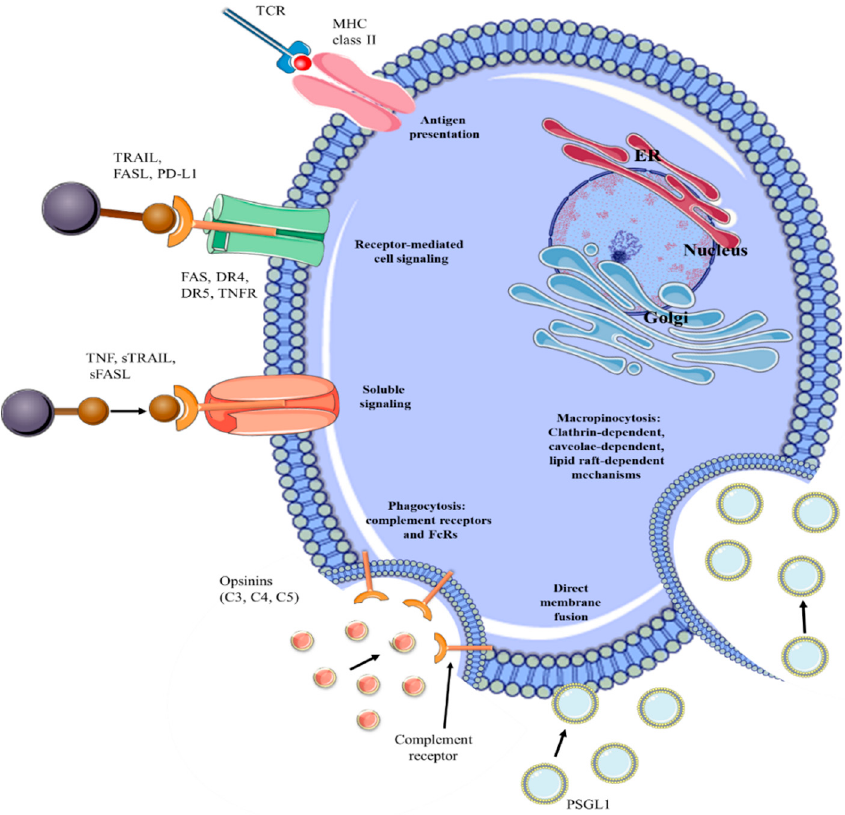
Figure 5. EV internalization by recipient cells through different mechanisms, including direct membrane fusion, macropinocytosis, endocytosis (clathrin- and caveolae-dependent mechanism, lipid-raft-dependent endocytosis) and phagocytosis (PI3K-dependent, dynamic-dependent, and actin-polymerization-dependent mechanism). The presence of ligand-receptors present on recipient cell surface can elicit biological responses and can targeted EVs (MHC—major histocompatibility complex, TCR—T cell receptor, TRAIL—TNF-related apoptosis-inducing ligand, FASL—FAS antigen ligand, PD-L1—programmed cell death 1 ligand 1, FAS—apoptosis-mediating surface antigen,